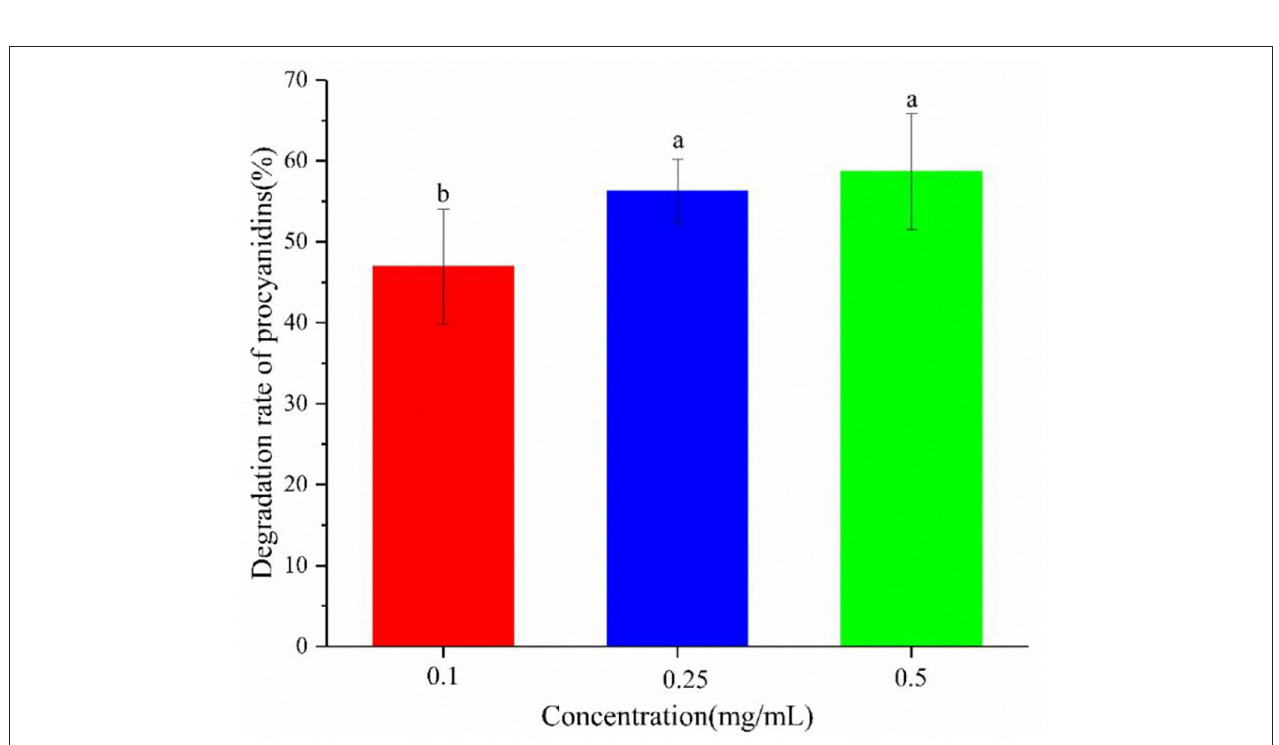
FIGURE 5 | Degradation rate of procyanidin in the yogurt-procyanidin groups. Different letters indicated significant differences ( P < 0.05).